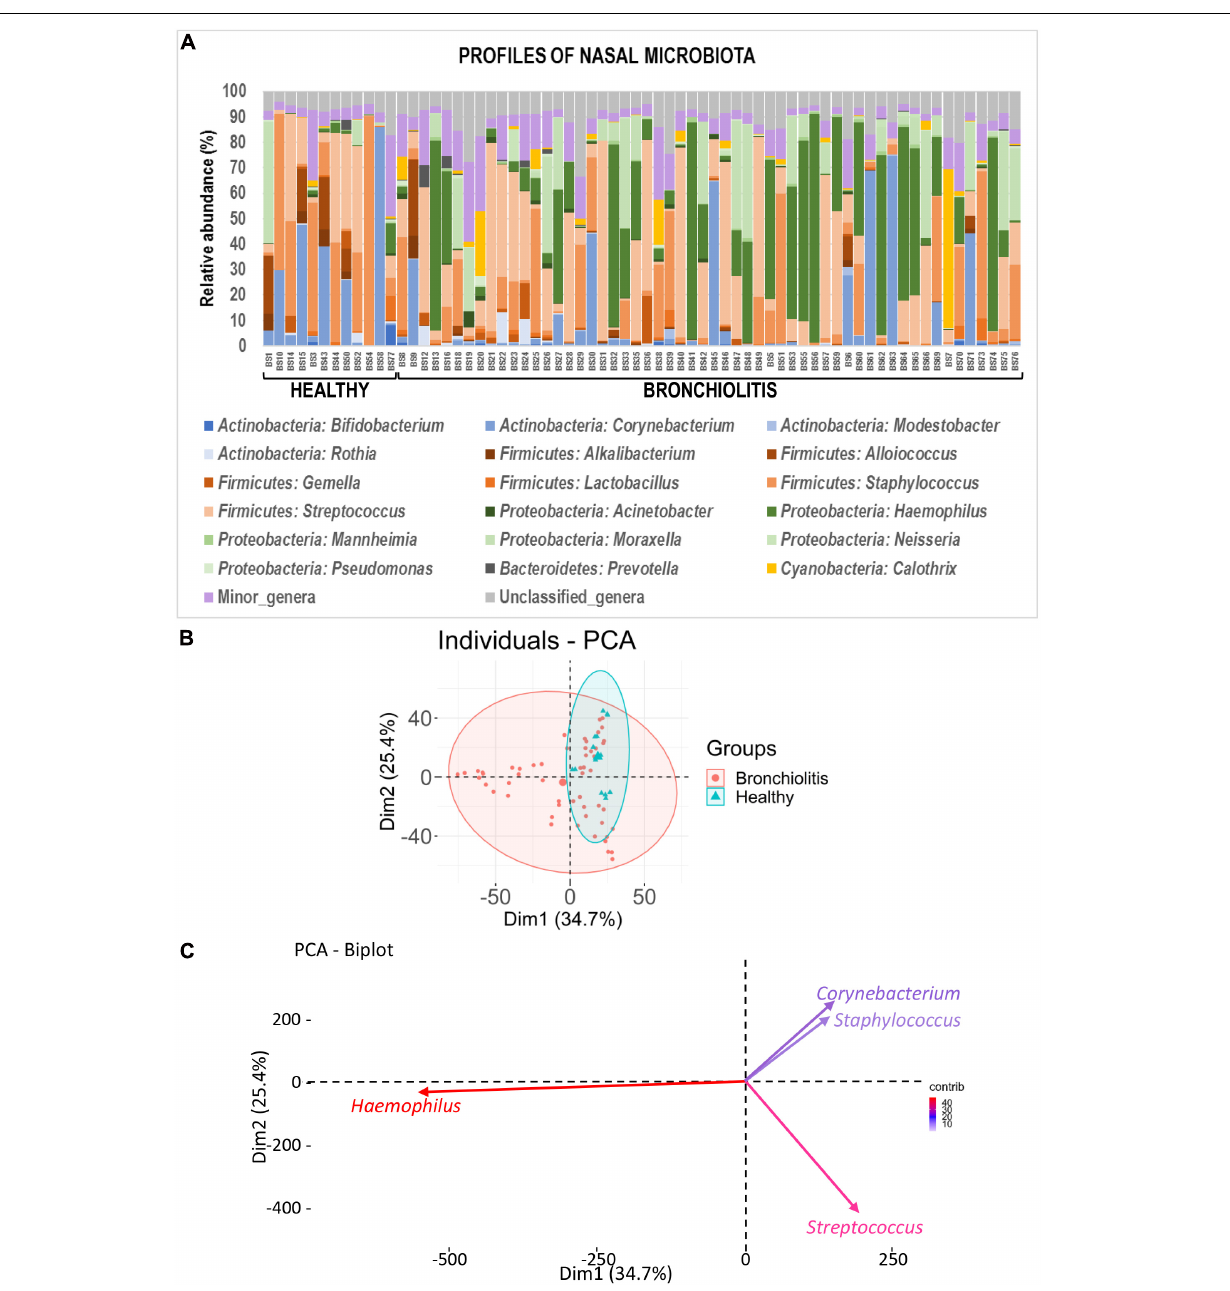
FIGURE 2 | Nasal microbiota in healthy controls and bronchiolitis groups. (A) Individual profiles of the microbiota composition at the genus level (the 20 most abundant genera) of nasal samples from healthy control and bronchiolitis groups. Each stacked bar represents one sample and depicts the average relative abundance of the most abundant bacterial genera (color-coded). (B) Principal component analysis (PCA) for nasal samples based on the bacterial composition at the genus level showing the sample distribution around centroids (ellipses were defined by a 95% confidence interval). (C) Most influential genera ( cos 2 > 0.2) on sample separation presented in panel (B)